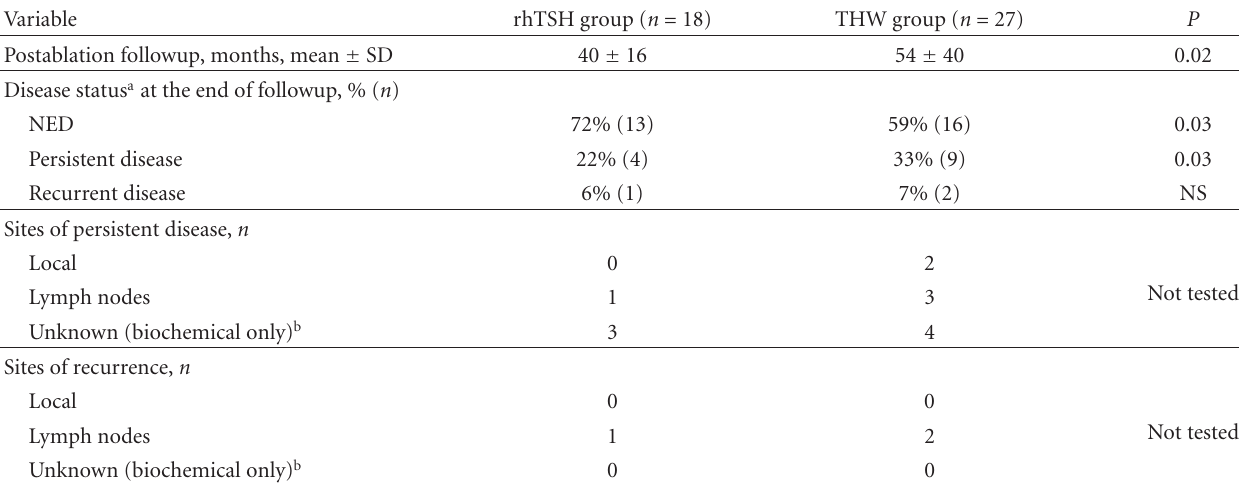
Table 3: Disease status at the end of